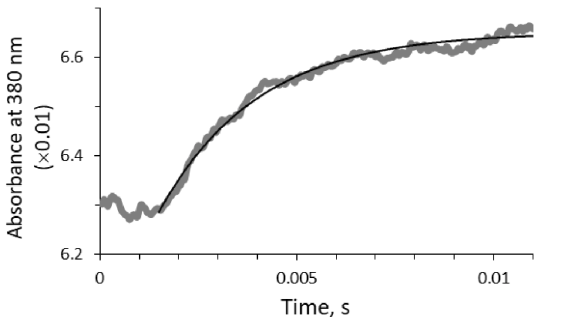
Figure 3. The absorbance change during C(4a)-hydroperoxyflavin intermediate formation in the buffer providing the rate constant k 2 . The gray thick line refers to the experimental kinetic curve, the black thin line—to the fitting curve with function D 380 = A · e − k 2 t + B